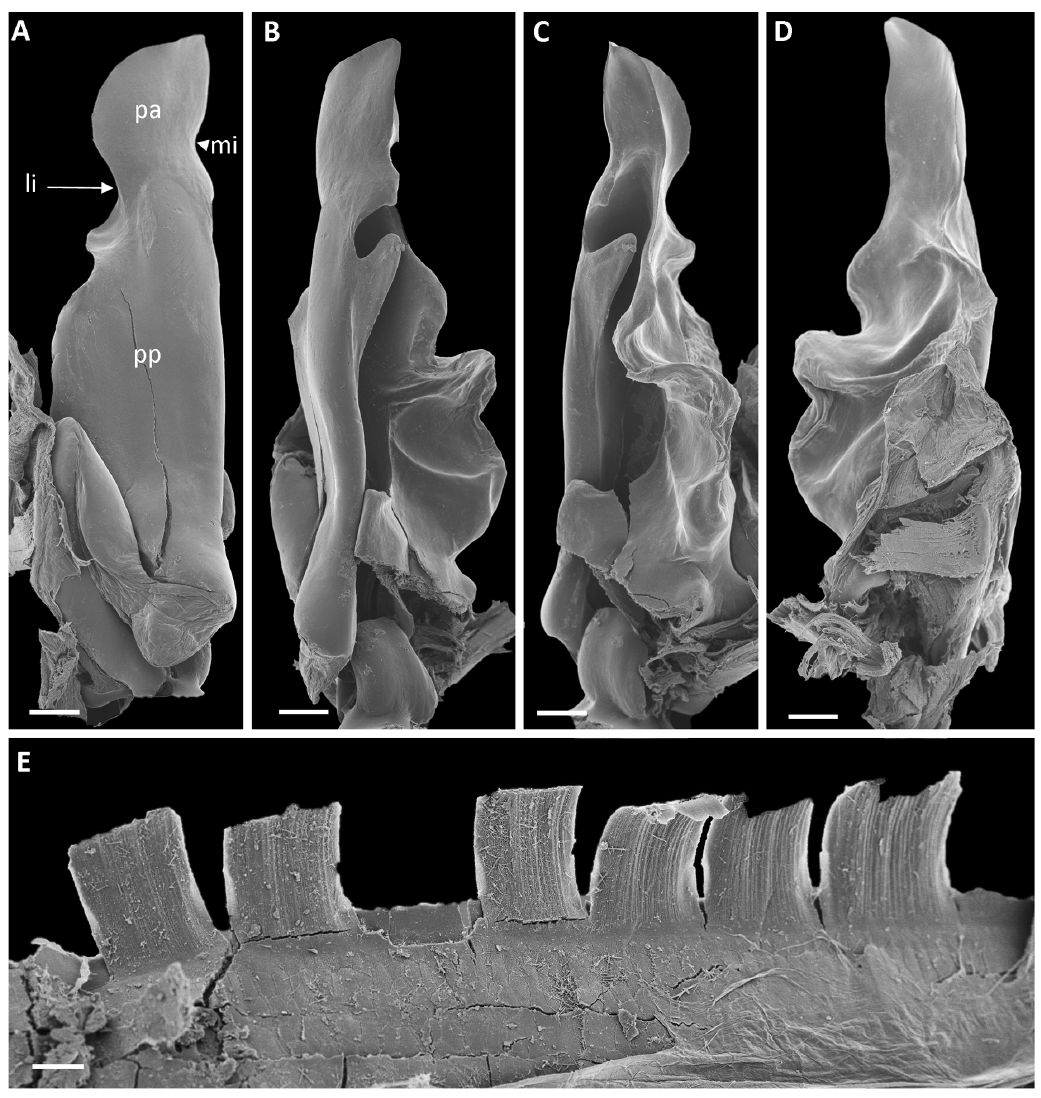
Fig. 12. Aquattuor mollilobus sp. nov., paratype, ♂ (NHMD 621648). A – D . Left gonopod coxa. A . Anterior view. B . Anterior-mesal view. C . Mesal view. D . Posterior-lateral view. E . Midbody dorsal limbus. Abbreviations: li = lateral incision; mi = mesal incision; pa = palette; pp = proplica. Scale bars: A–D = 0.1 mm; E = 0.02